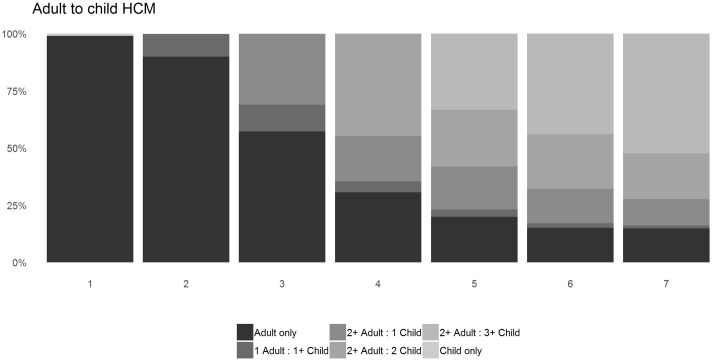
Adult to child HCM.